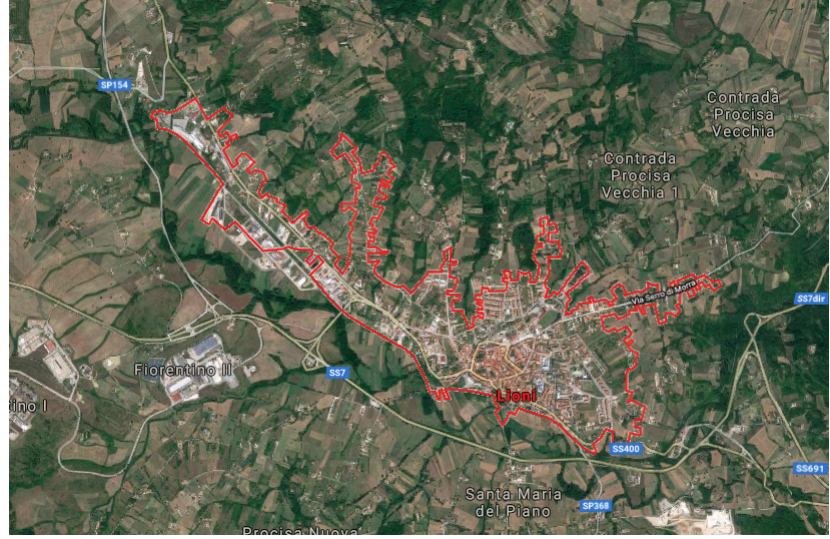
Figure 1. Lioni: Immages@2019 Google, Immages@2019 CNES/Airbus, Landsat/Copernicus, Maxar Technologies, Cartographic data (October